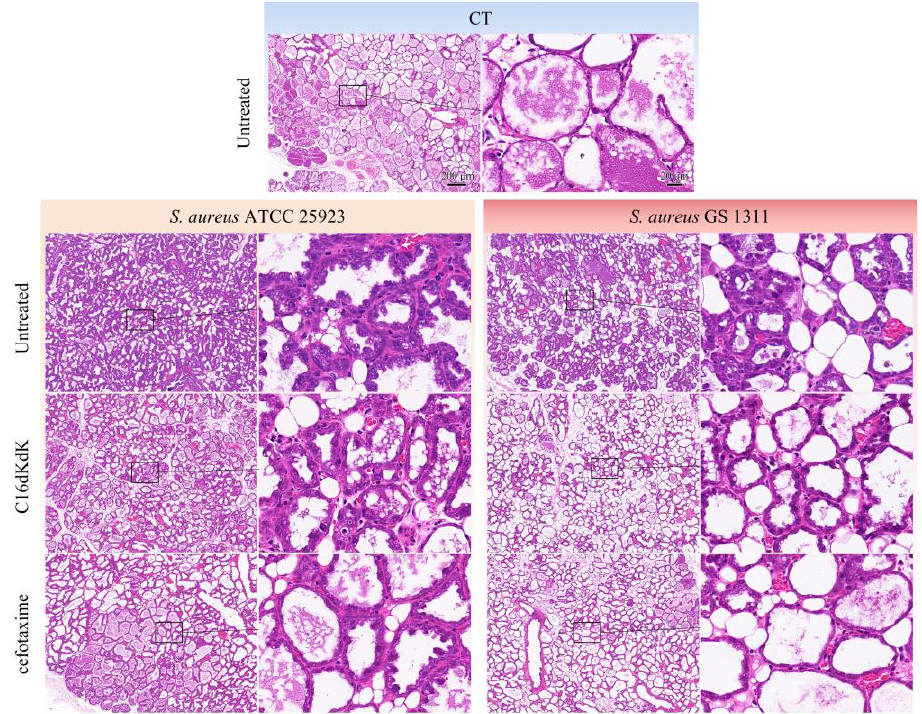
Figure 5. Histopathological examination of mammary glands of mice. The mammary gland tissues were fixed in formalin and then sectioned and stained with H&E. Microscopic observation. “CT”, “ATCC25923,” and “GS1311” denote the healthy mice group, S. aureus ATCC25923-infected group and S. aureus GS1311-infected group, respectively. “Untreated” indicates no treatment, “C16dKdK” indicates treatment with C16dKdK after infection, and “cefotaxime” indicates treatment with cefotaxime after infection. Each group’s left and right columns are shown in the images collected at 10× and 40×, respectively.